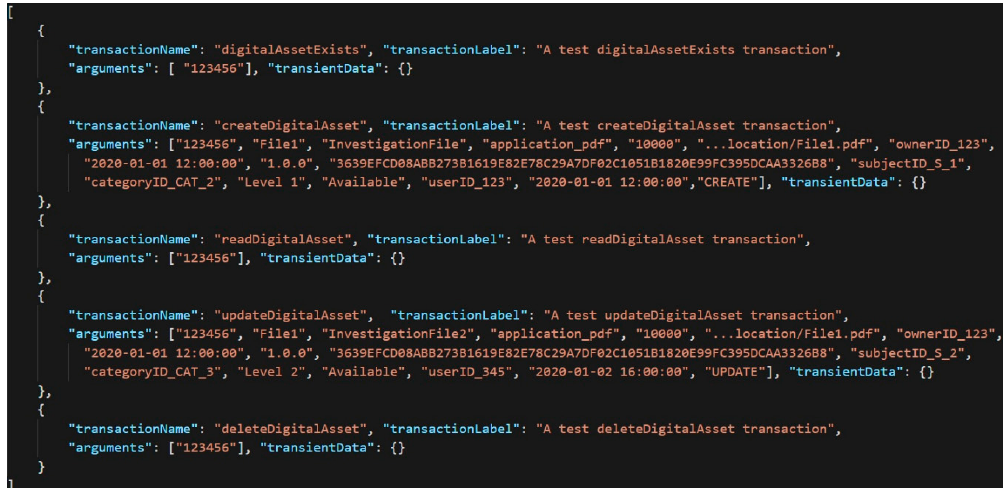
Figure A2. Transactions data file (TDL).